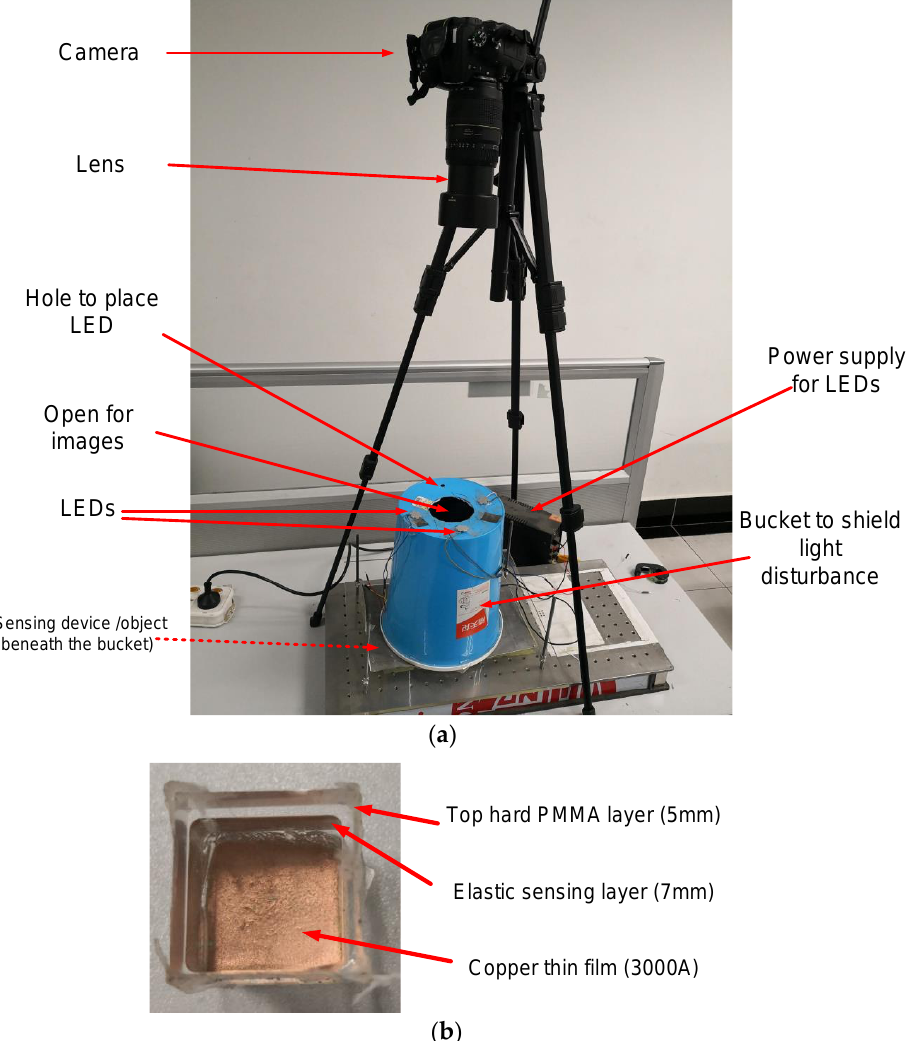
Figure 9. Experiment setup: ( a ) image acquisition, ( b ) sensing device with sensing film at the bottom.